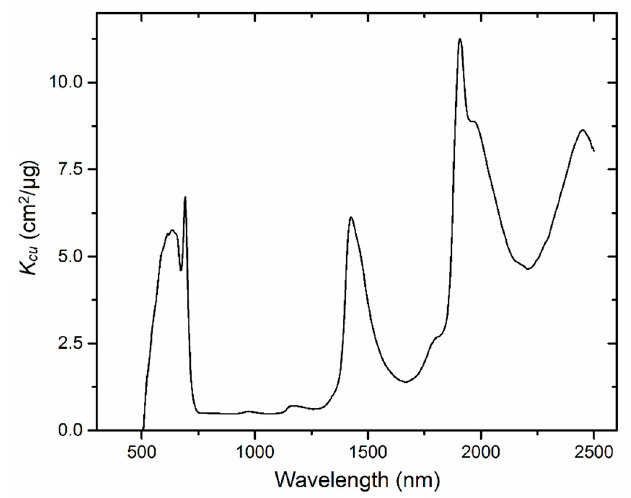
Figure 6. The specific absorption coefficient related to copper ( K cu ).